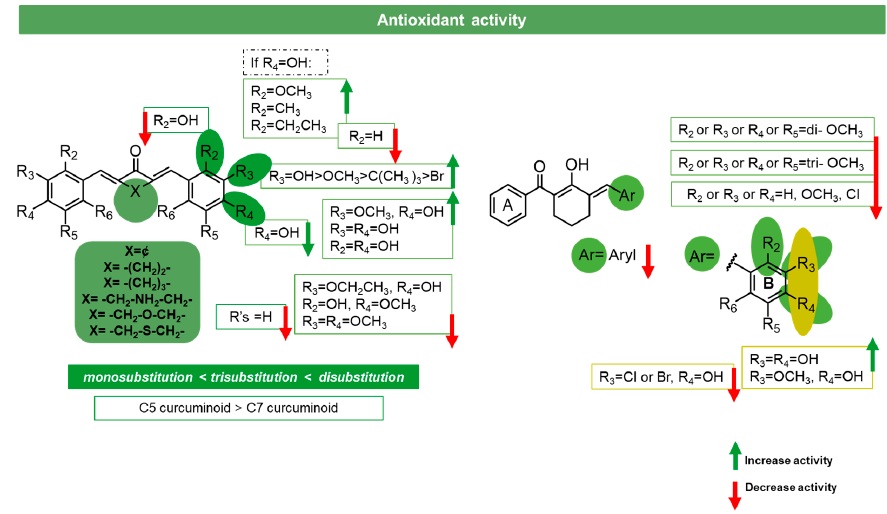
Figure 7. Putative SAR for the antioxidant activity of diarylpentanoids.